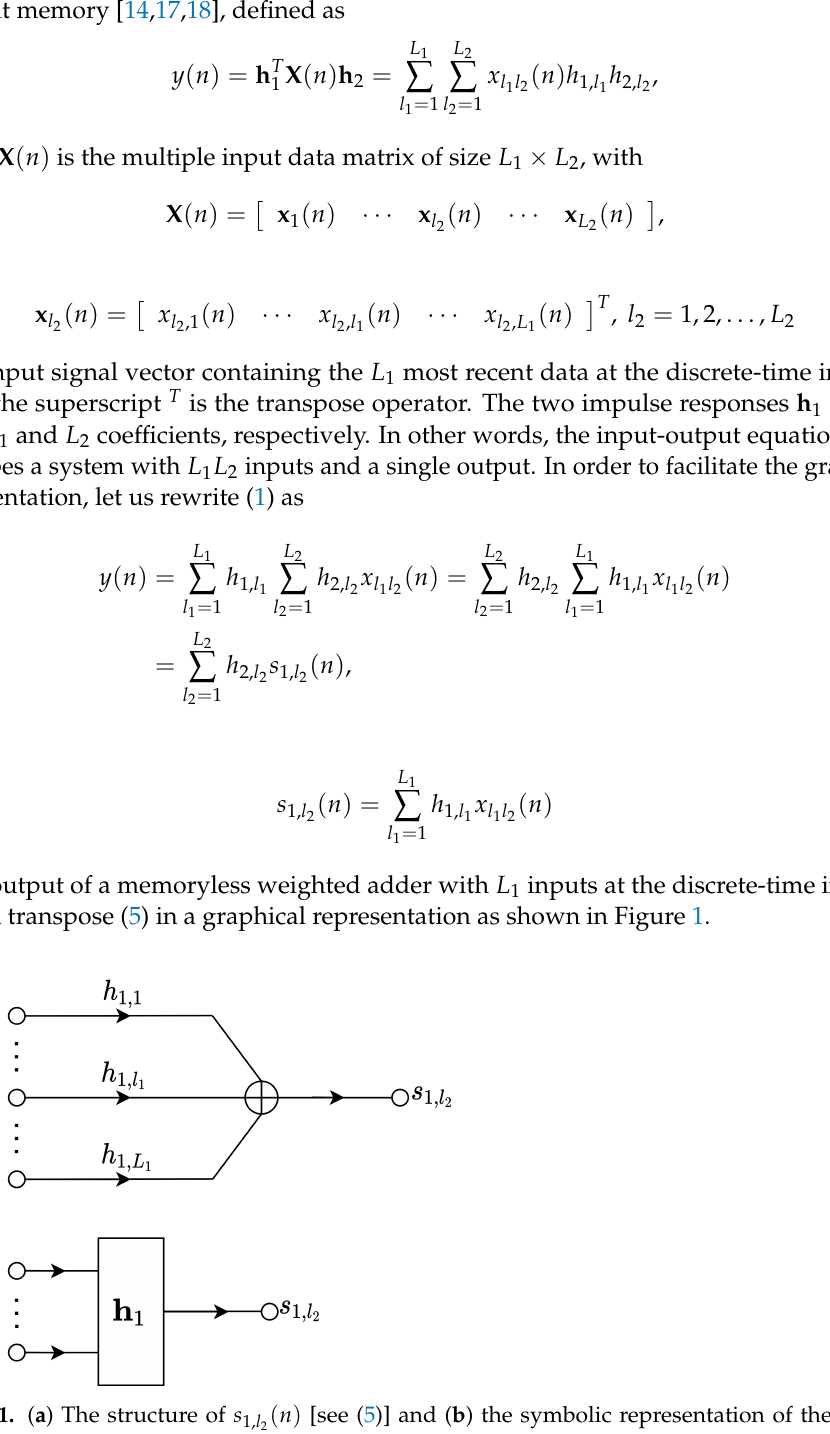
Figure 1. ( a ) The structure of s 1, l memoryless weighted